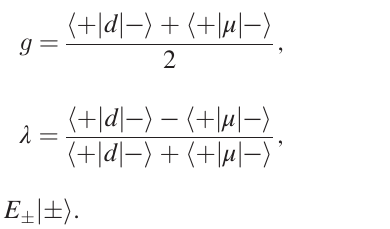
lines in Fig. 3(b)]. At the points of level crossings, the